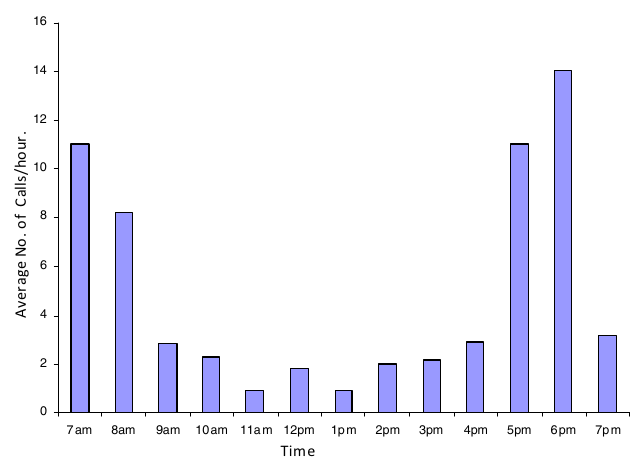
Figure 2. Average number of rutting